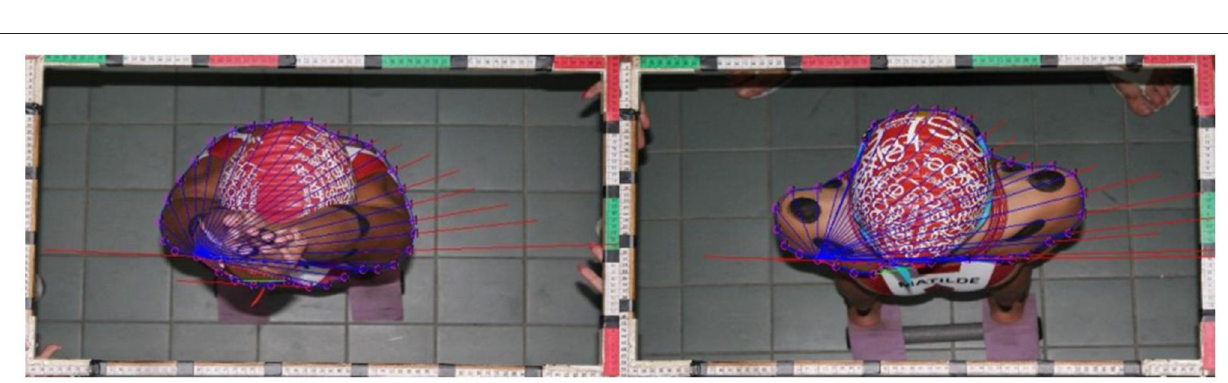
Frontiers in Sports and Active Living |